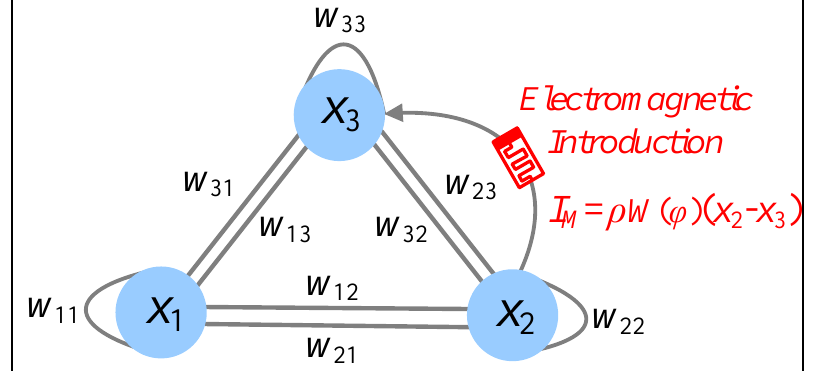
Figure 4. Connection topology of an MHNN under an internal electromagnetic field.